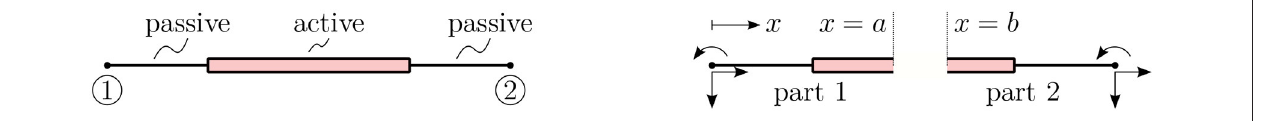
FIGURE 1 | Active beam element (left) and degrees of freedom to connect the element to the rest of the structure (right)